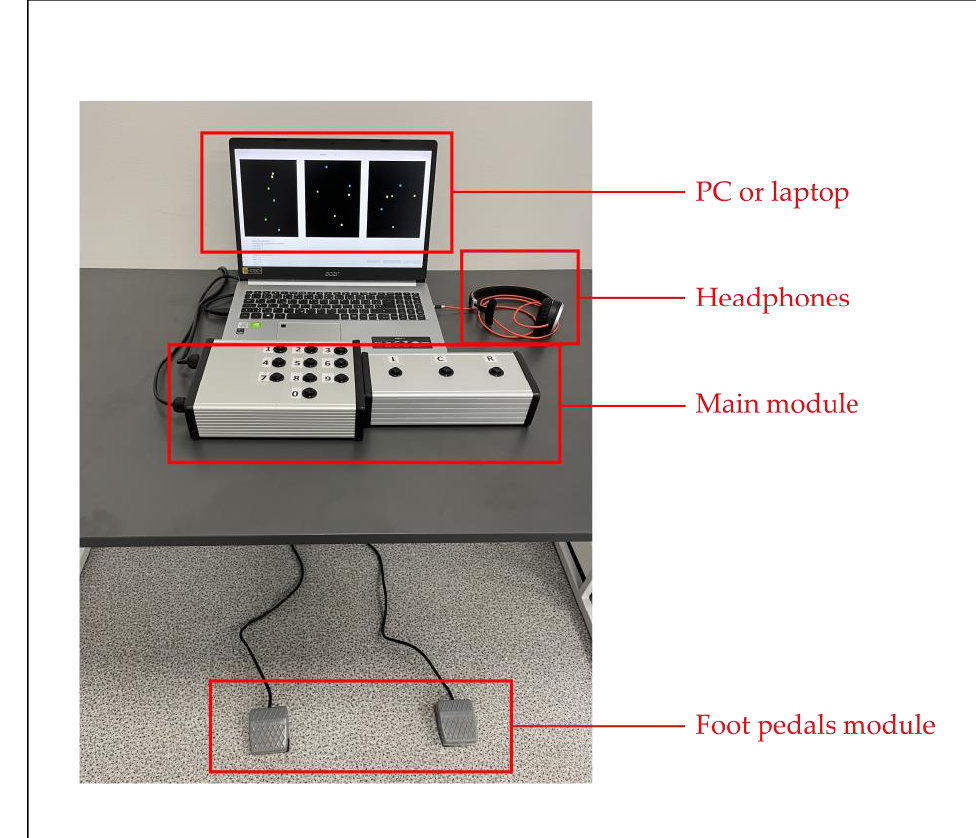
Figure 2. Photo of the testing device.